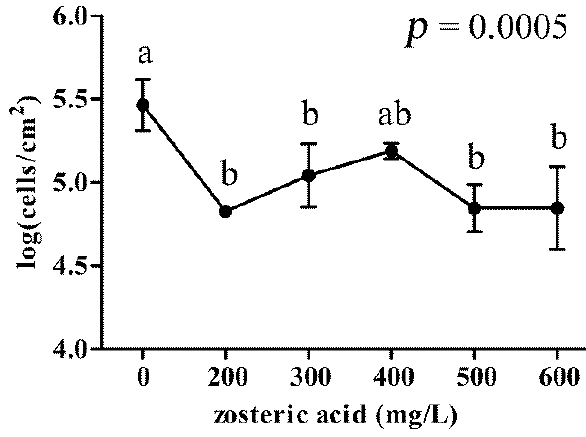
Figure 3. P. putida cells adhesion in presence of different concentrations of zosteric